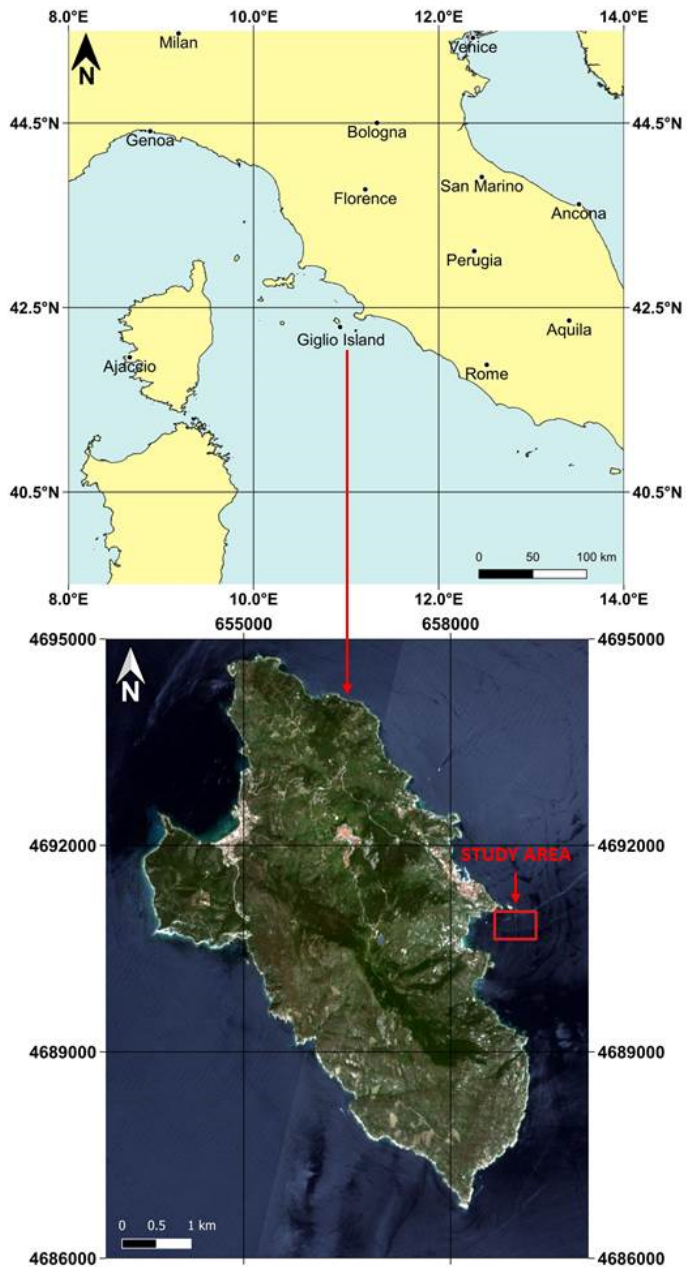
Figure 2. The study area in equirectangular projection and WGS84 geographic coordinates (EPSG: 4326) ( top ). Visualization of Giglio Island (RGB composition of Sentinel-2B images) in UTM/WGS 84 plane coordinates expressed in meters (EPSG: 32632) ( bo tt om ).